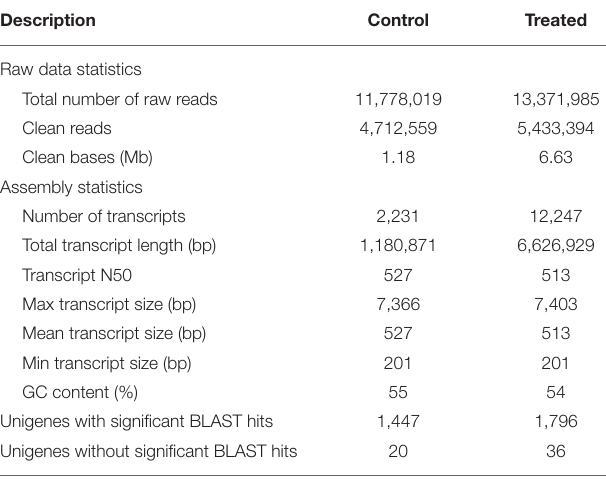
TABLE 2 | Raw data and assembly statistics for transcriptomes from M. glaucescens explants. Description